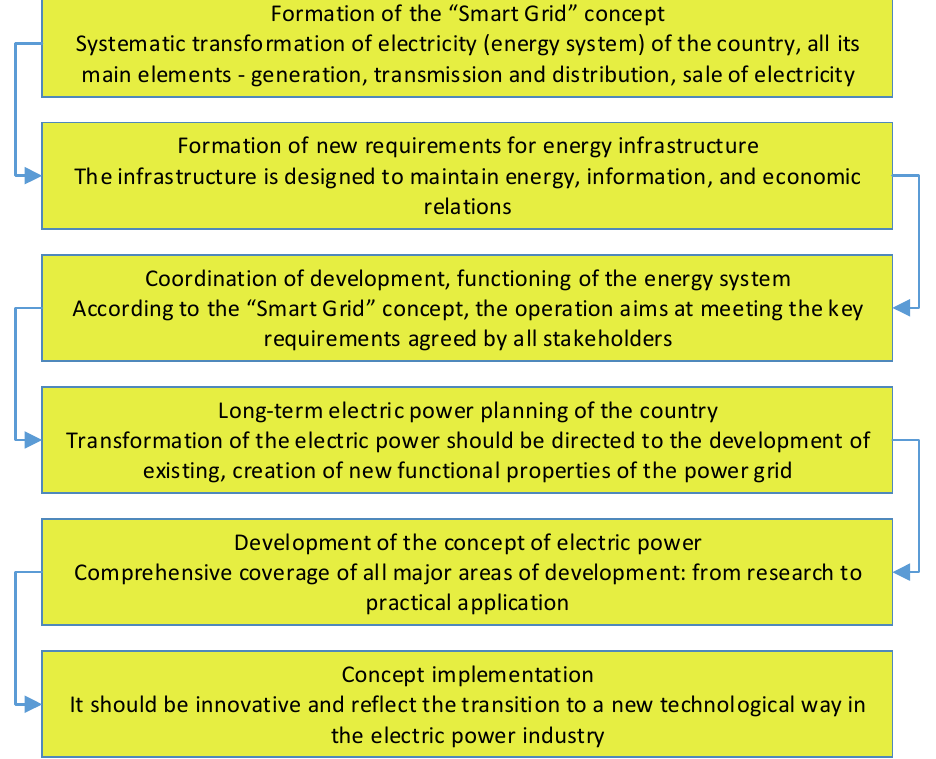
Fig. 3: Stages of “Smart Grid“ implementation in the electric system of a country